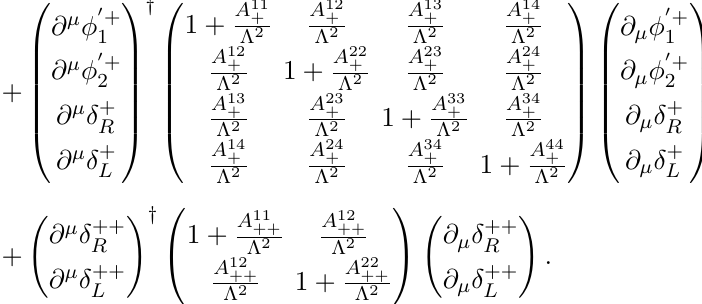
2 = 42] class of (cid:2)